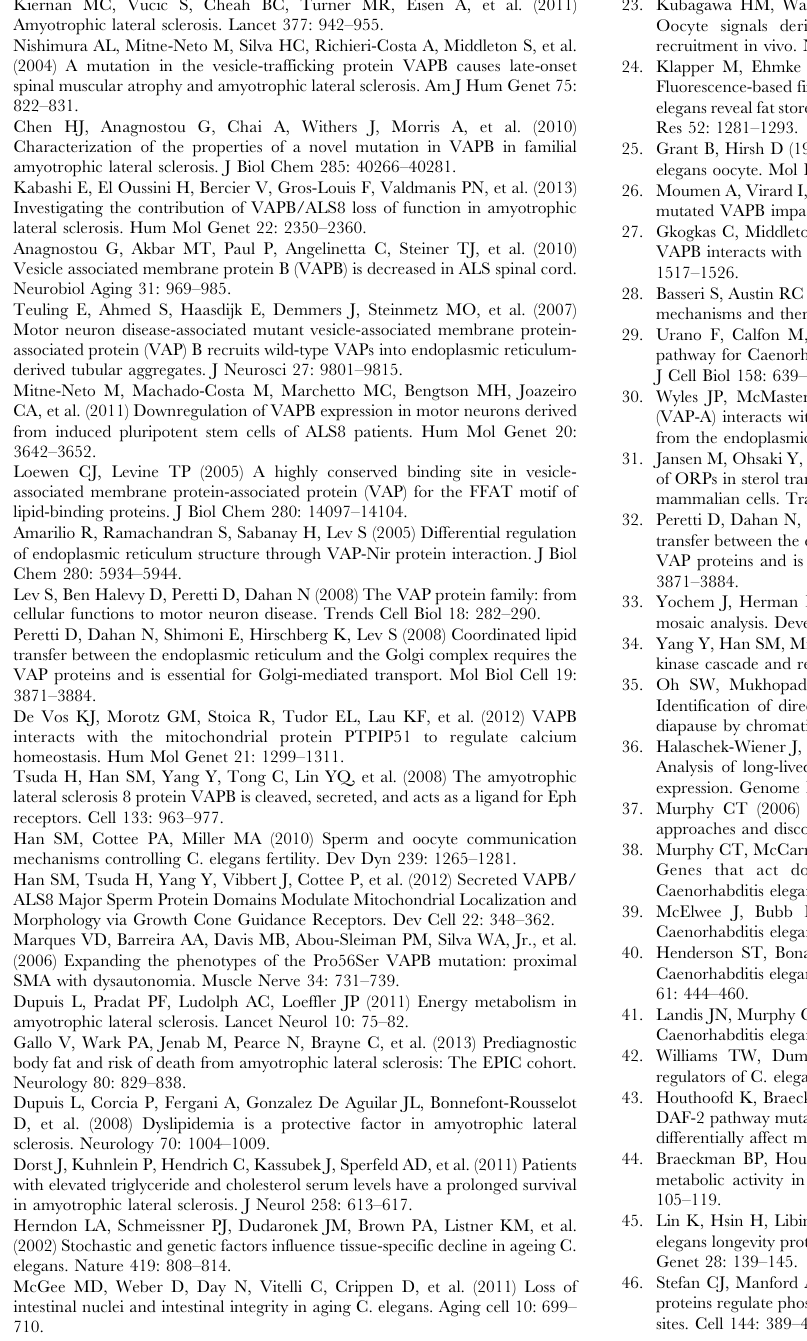
Table S1 Primers used for RT-qPCR in mice.